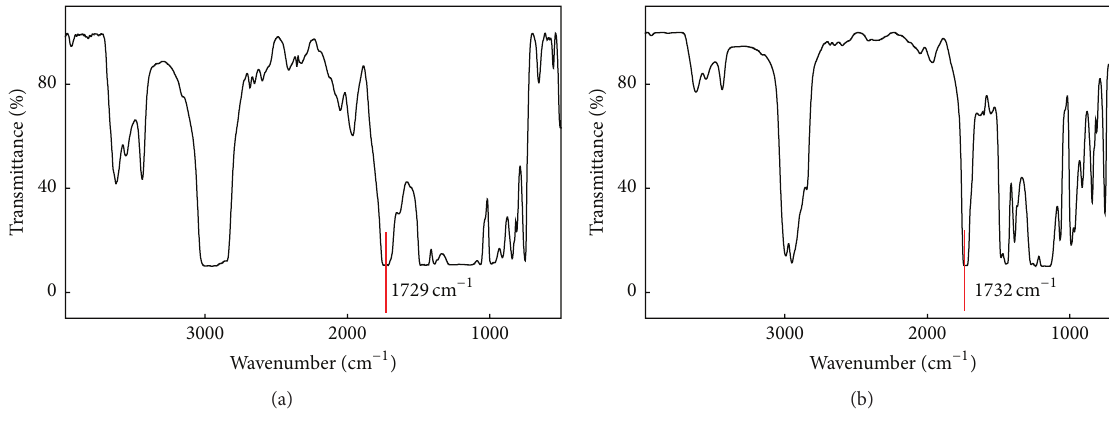
Figure 1: FTIR spectra of (a) PMMA and (b) 1wt% TBA incorporated